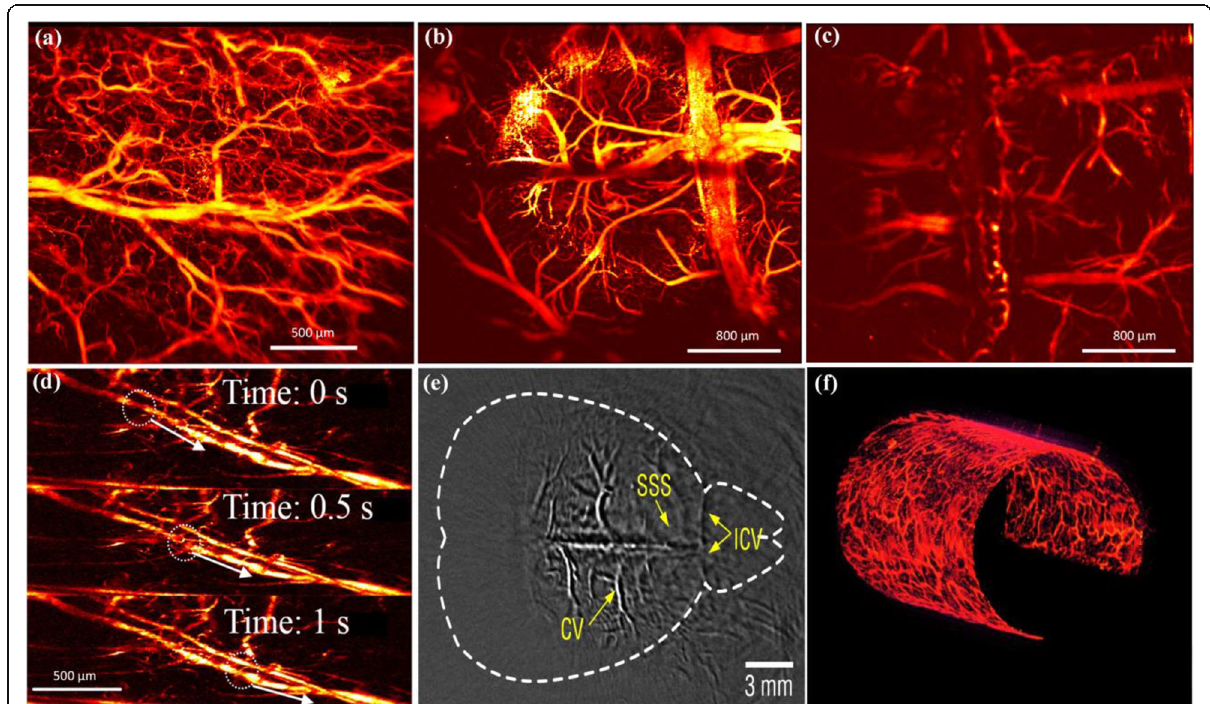
Fig. 9 In vivo PAI using the fiber-laser ultrasound sensor. ( a ): Fast-scanning optical-resolution PAM of mouse ear; ( b ) and ( c ): In vivo imaging of the mouse brain ( b ) without and ( c ) with intact skull; ( d ): Three consecutive snapshots showing the negative contrast flow in a blood vessel; ( e ): In vivo photoacoustic computed tomography of a mouse brain; ( f ): In vivo endoscope image of a rat rectum [58,